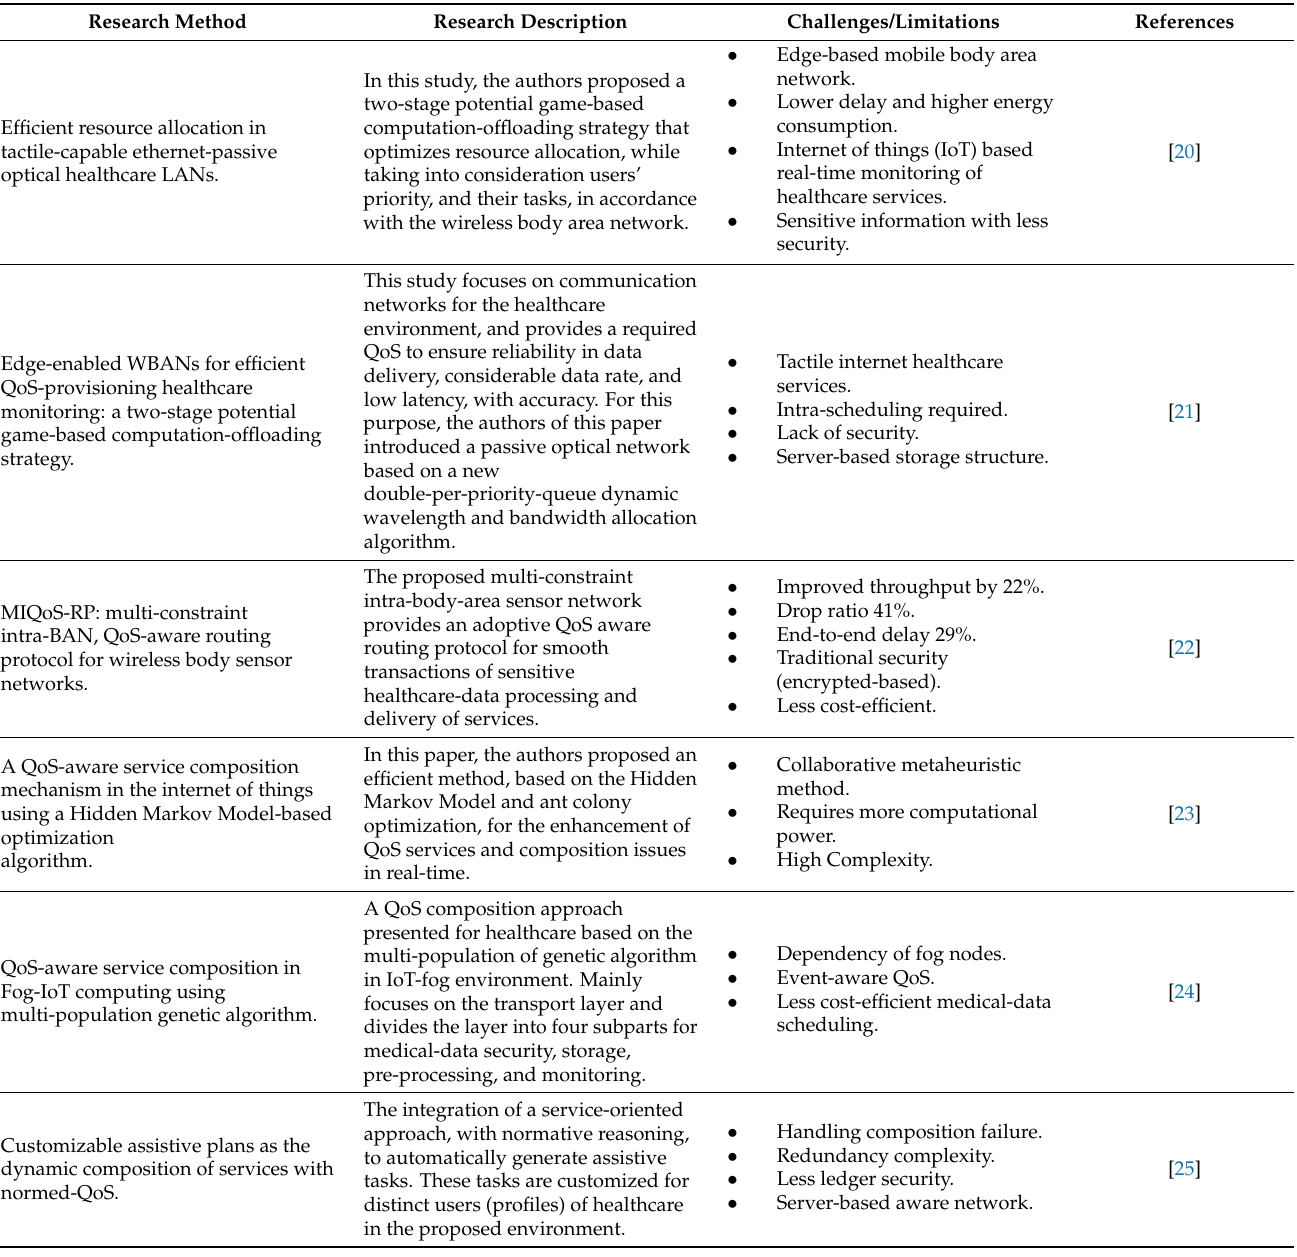
Table 1. Related literature on QoS and cost-efficient scheduling